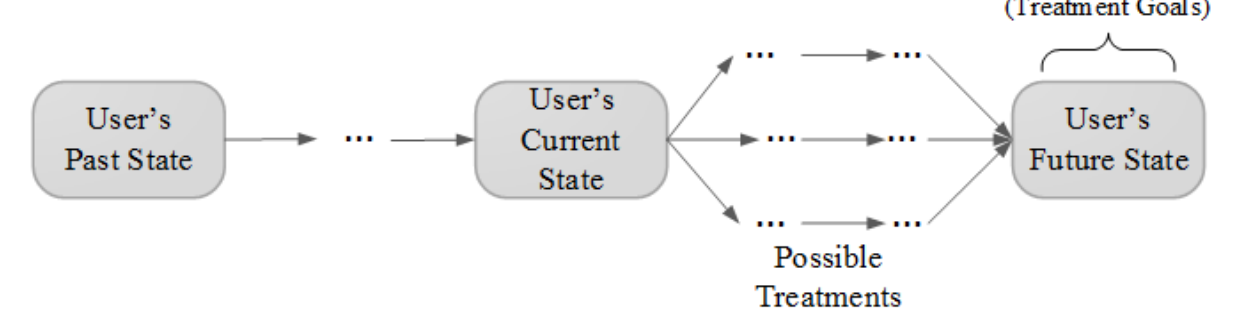
Figure 1. BITs facilitate reaching future changes (ie, intervention aims) through possible